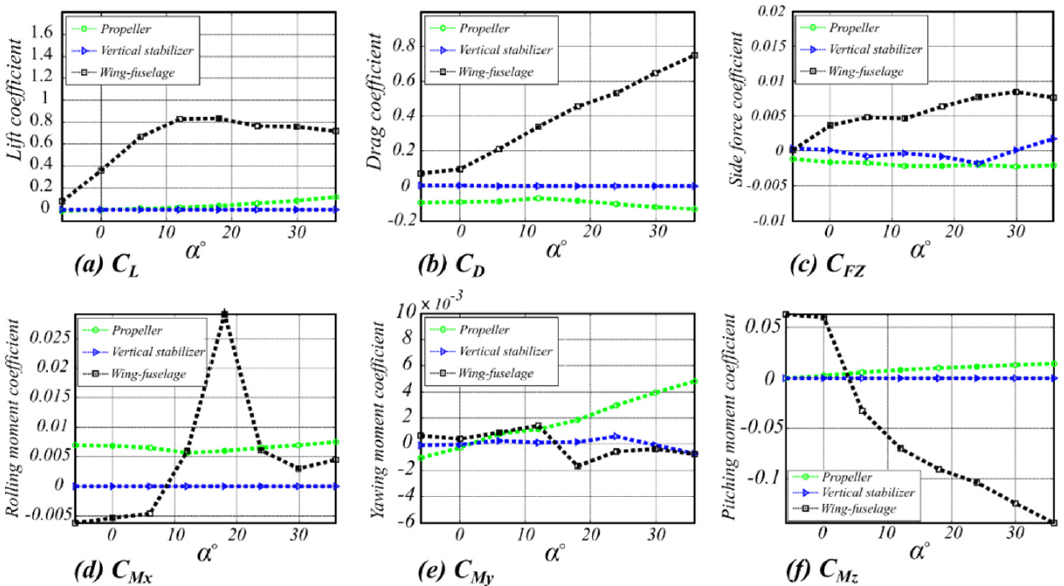
Figure 7. Averaged aerodynamic coefficients versus α at J = 0.468, (a) lift coefficient, (b) drag coefficient, (c) side force coefficient, (d) rolling moment coefficient, (e) pitching moment coefficient, and (f) yawing moment coefficient.